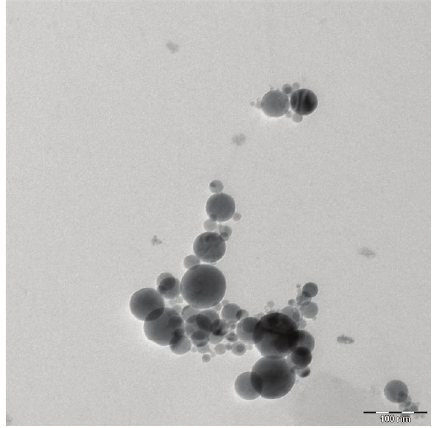
Figure 8: TEM image for CSNC2 (4wt.% of Al 2 O 3 ).